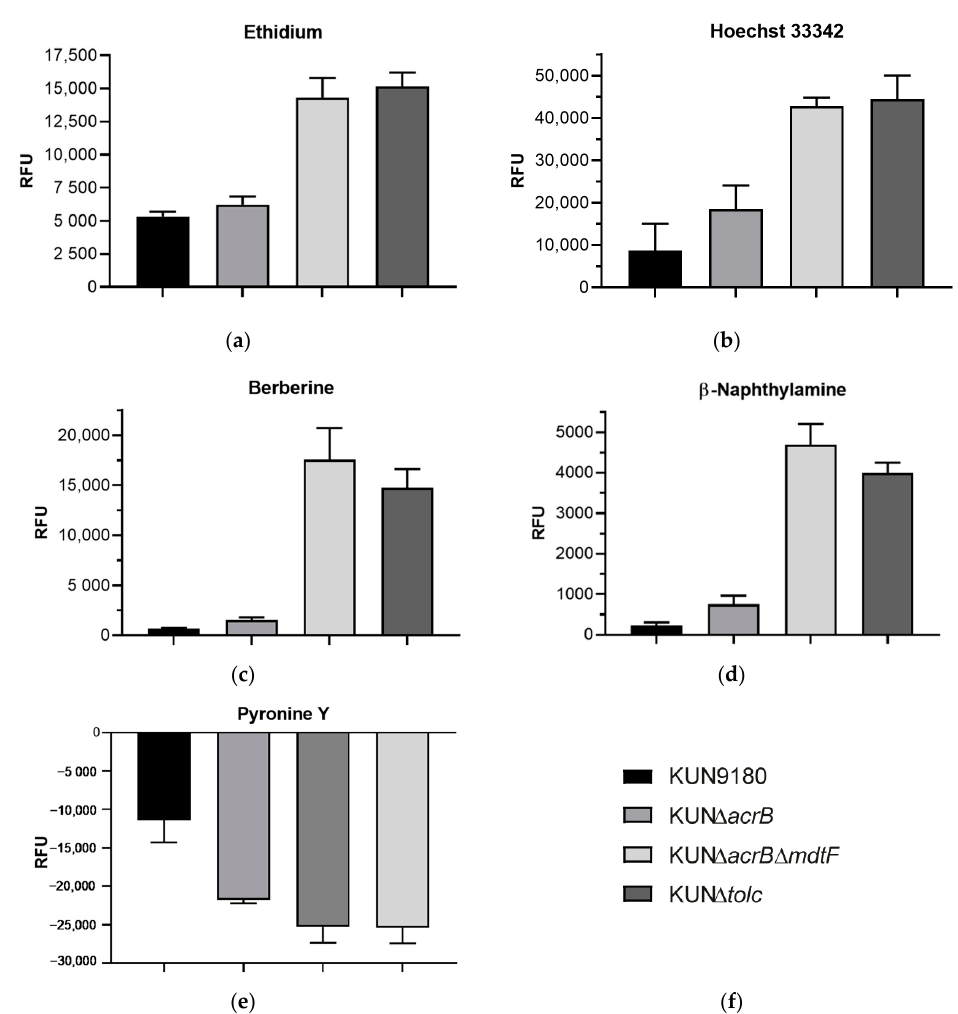
Figure 1. Accumulation of dyes in isolate KUN9180 and derived mutants (RFU, relative fluorescence unit; bars represent means of ≥ 3 assays ±SD from values at 30 min, for Pyronine Y at 20 min of incubation): ( a ) ethidium; ( b ) Hoechst 33342; ( c ) berberine; ( d ) β -naphthylamine; ( e ) quenching of fluorescence by intracellular accumulated Pyronine Y (lower fluorescence values reflect higher accumulation of Pyronine Y). ( f ) Graph legend for panels ( a – e ).